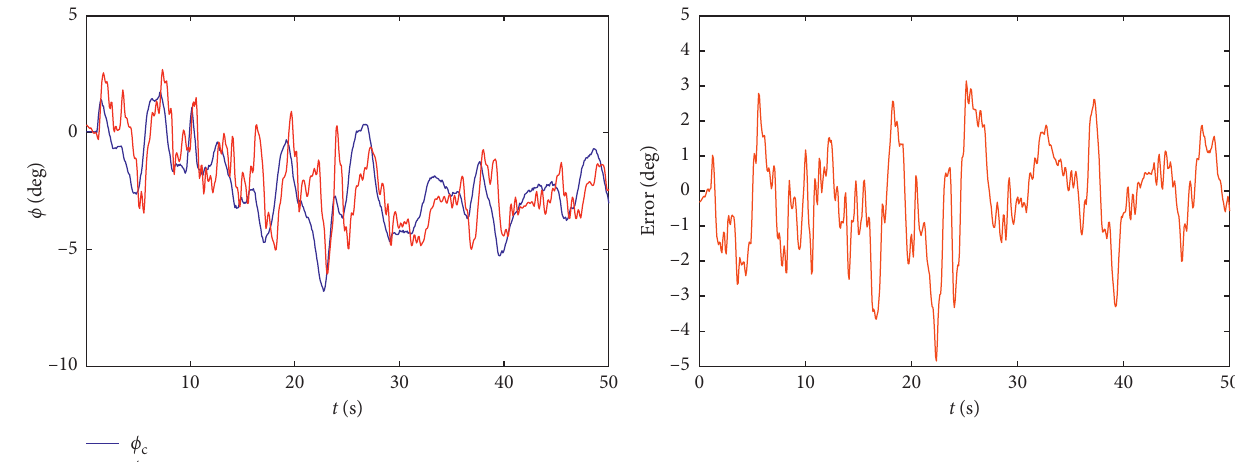
Figure 17: Roll control and tracking error of the RSLQR controller with